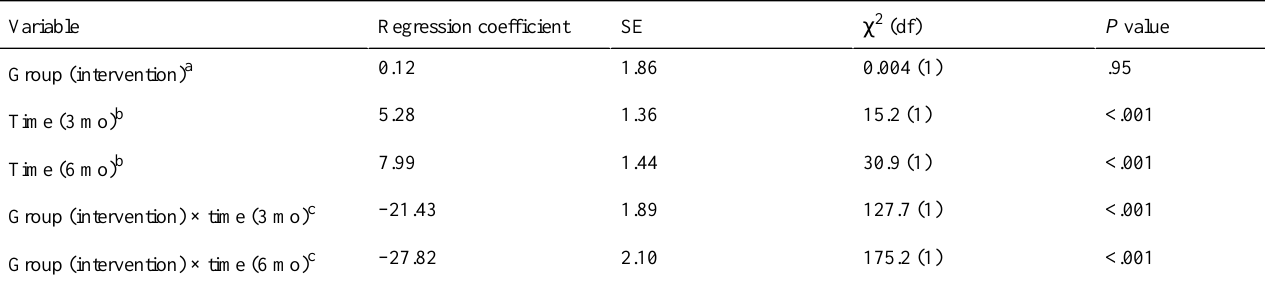
Table 1. Generalized estimating equation analysis of the effect of the intervention on systolic blood